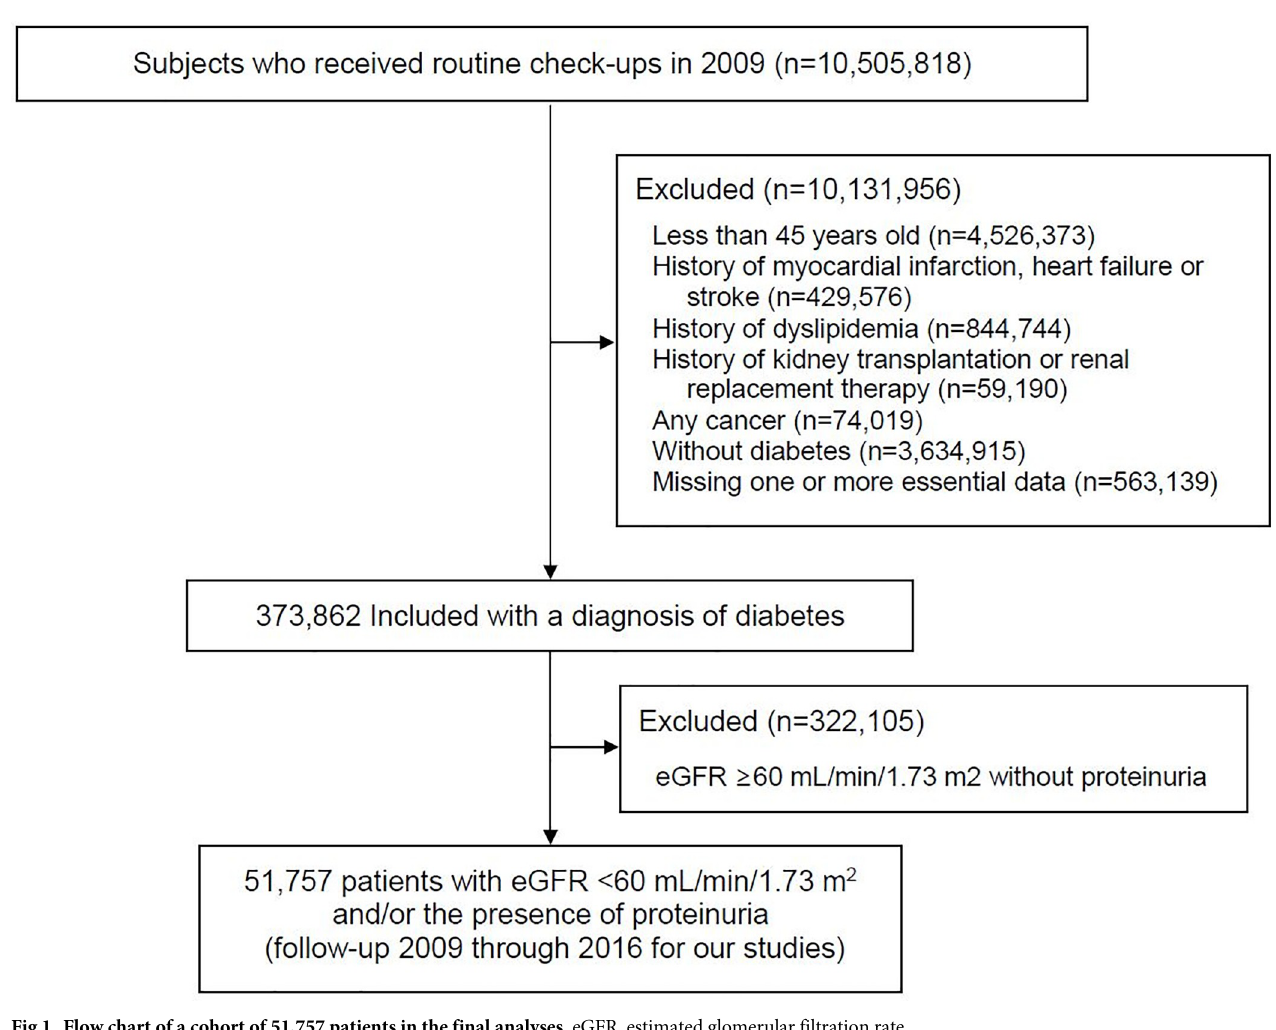
Fig 1. Flow chart of a cohort of 51,757 patients in the final analyses. eGFR, estimated glomerular filtration rate.